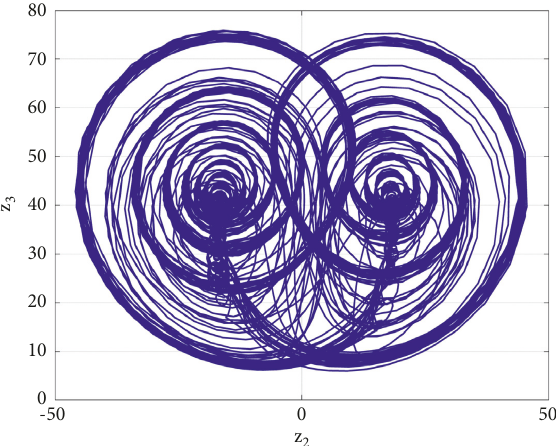
Figure 17: A chaotic attractor of the 4-D system (1) when c � 40 and ( a,b, d ) � ( 25 , 8 , 6 ) .